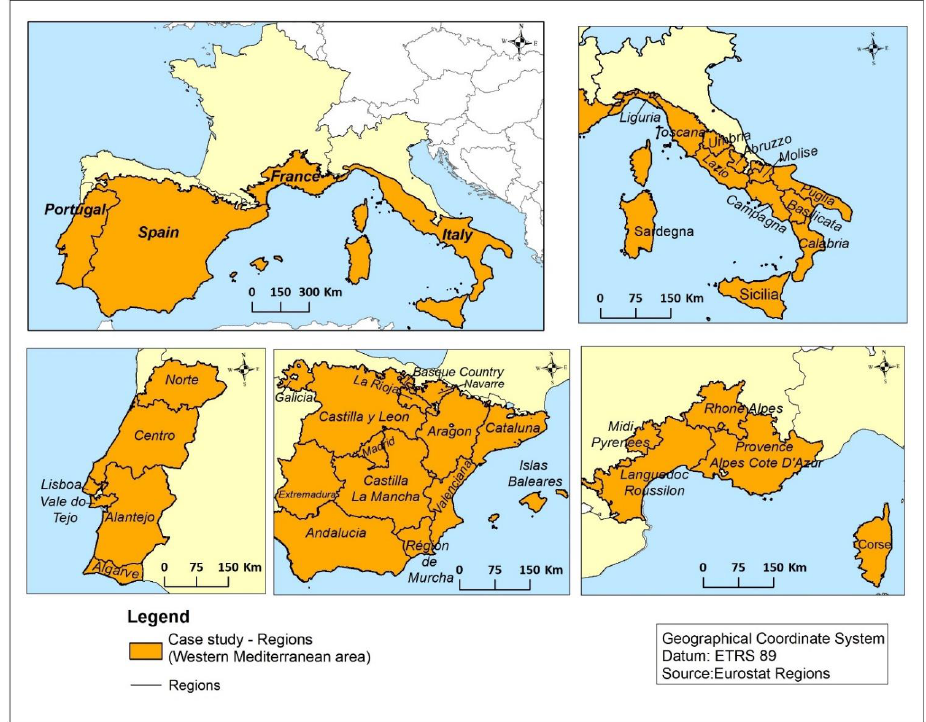
Figure 1. The study area and the regions present in each country. Table 1. National surface, surveyed surface (in kha and %), land administrative units (LAUs) (in number and %), and the average size of LAU for each country.